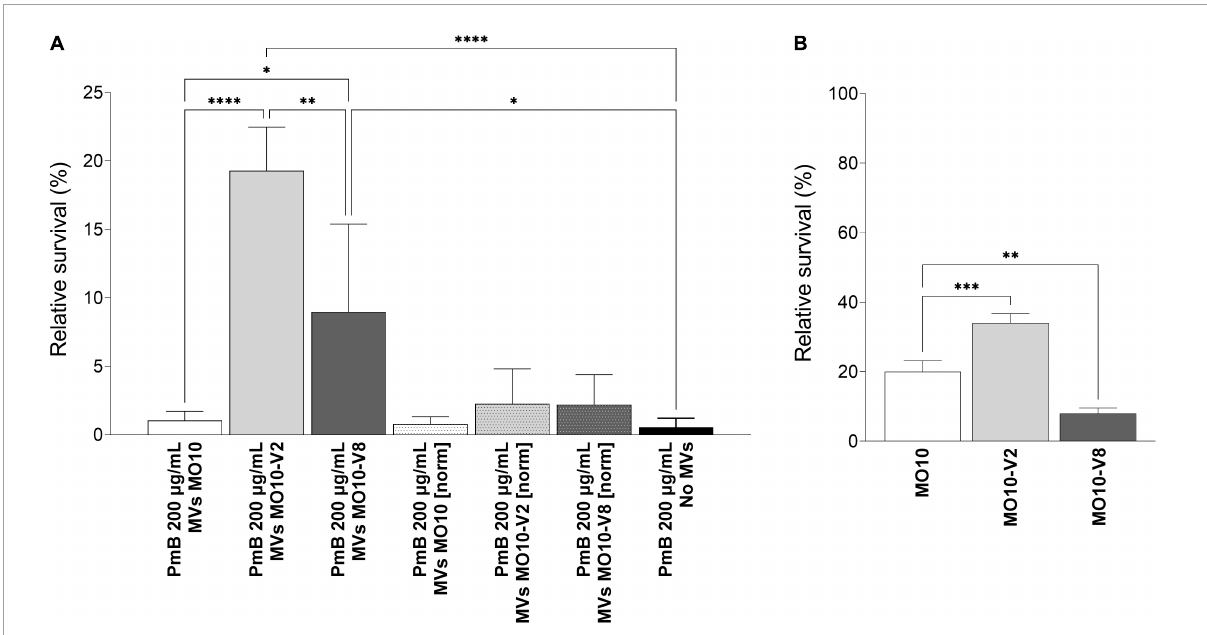
FIGURE8 Relative survival to lethal concentration of polymyxin B. (A) Relative survival of MO10-WT in the presence of 200 µ g/mL of PmB for 1 h, with or without MVs from MO10-WT, -V2, or -V8, normalized (MVs MO10-WT [norm], MVs MO10-V2 [norm], and MVs MO10-V8 [norm]) to the same concentration or not (MVs MO10-WT, MVs MO10-V2, and MVs MO10-V8). (B) Relative survival of MO10-WT, -V2, or -V8 after 30 min in the presence of a lethal concentration of PmB. Data are presented as mean ± standard error from at least 3 independent experiments. The % of survival was calculated in comparison with the condition without PmB ( p ≥ 0.05; * p < 0.05; ** p < 0.01; *** p < 0.001; **** p <